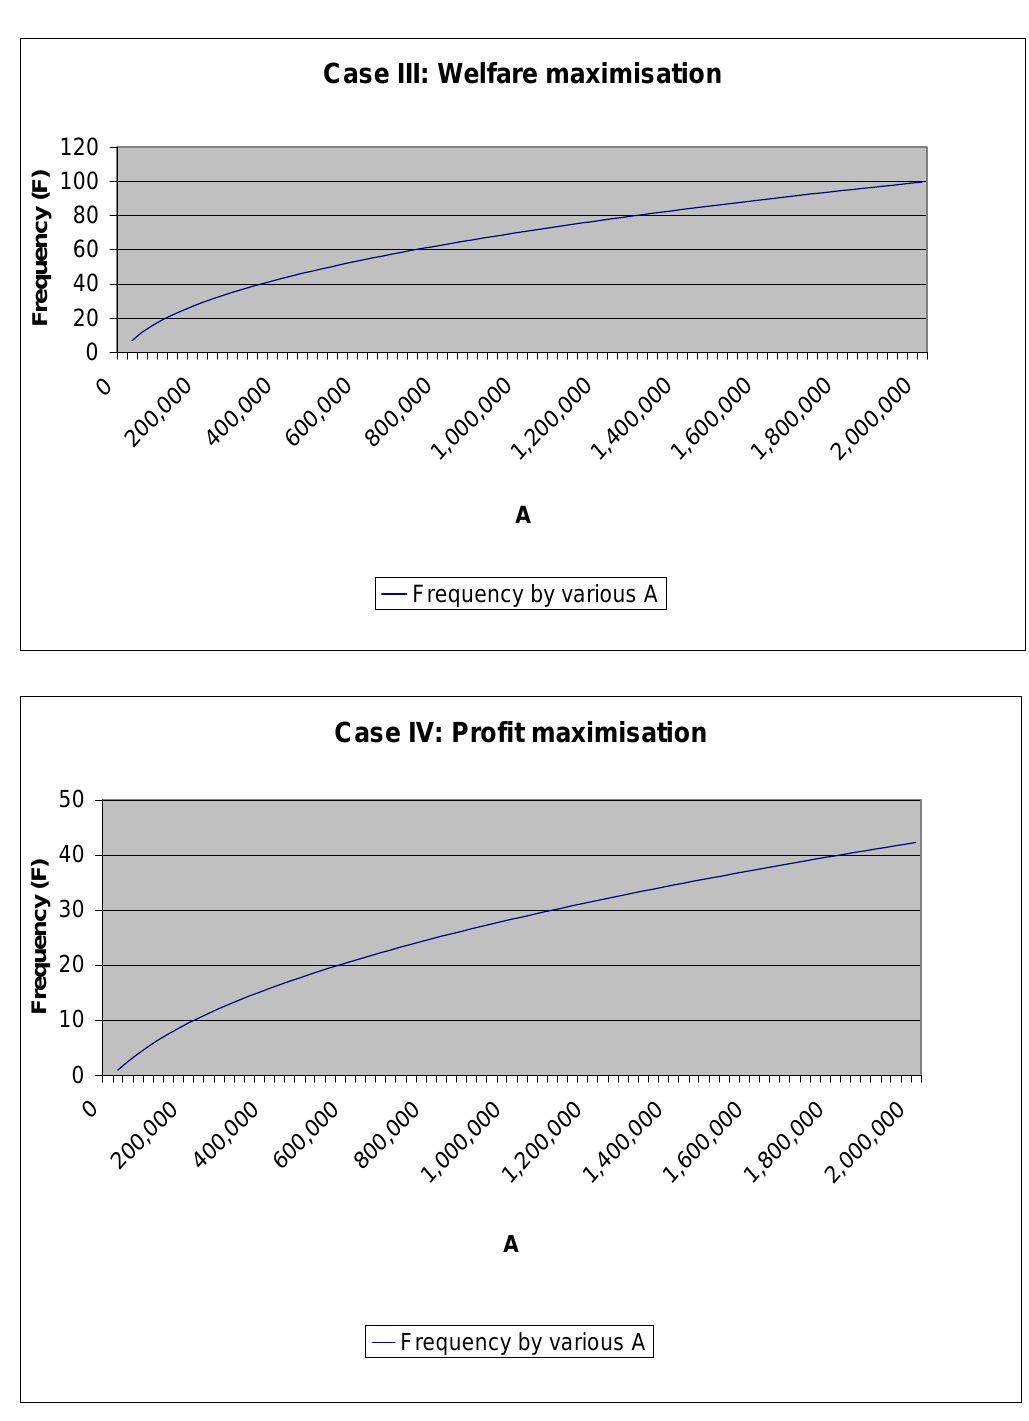
Figure 3. Relationship between travel demand and vehicle size under elastic demand, welfare maximisation (III) and profit maximisation